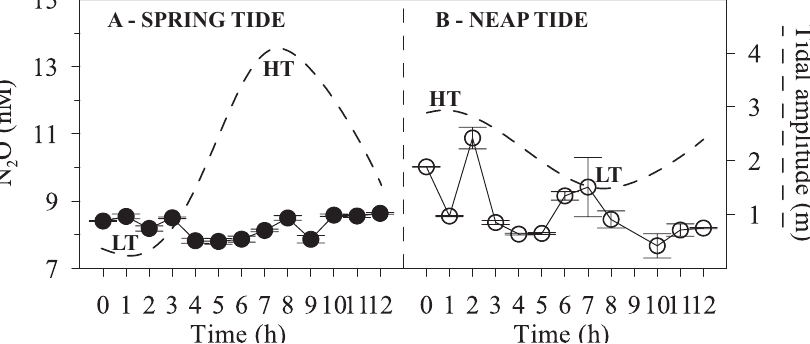
Fig . 6. – Variability of dissolved nitrous oxide (N